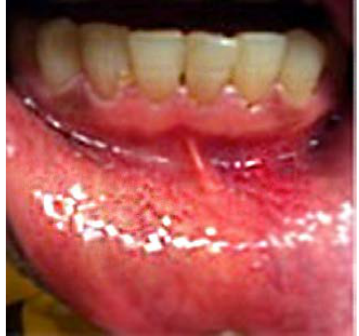
Figure 6. 72 h post-op extra-oral swelling reduced.